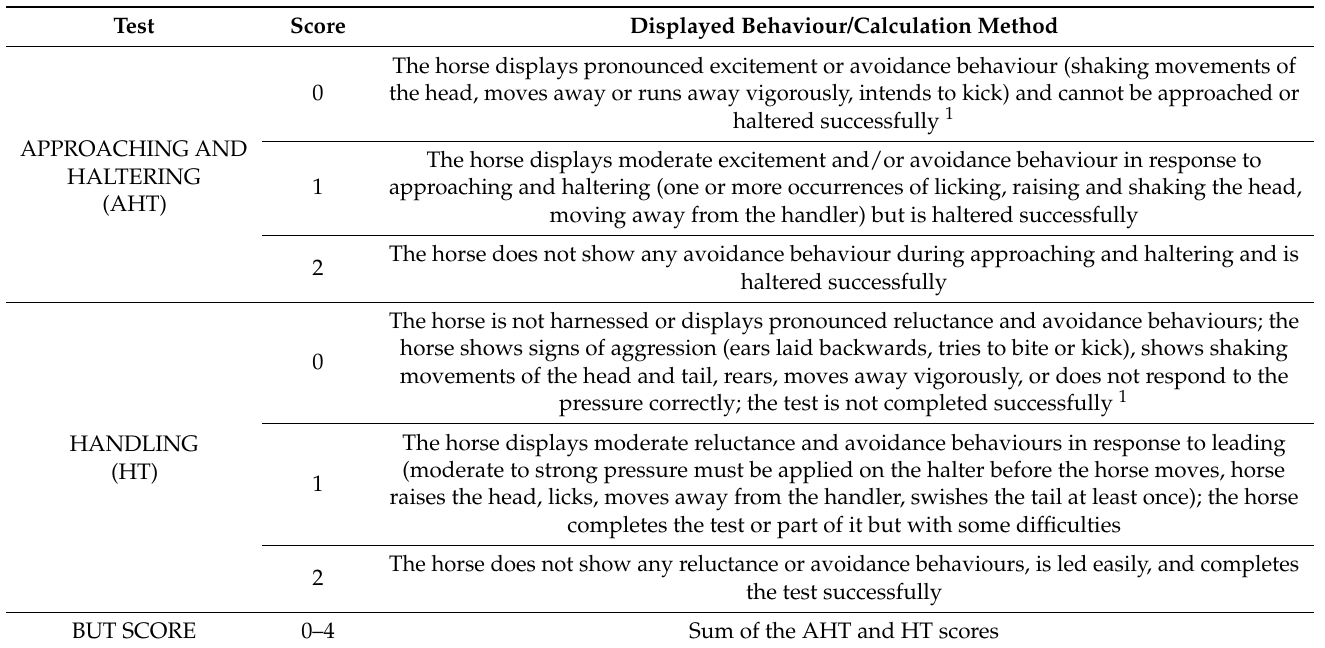
Table 1. Scoring system for classification of horses’ behaviour during the Approaching and Haltering Test (AHT) and Handling Test (HT), and calculation of the Broken/Unbroken Test (BUT)